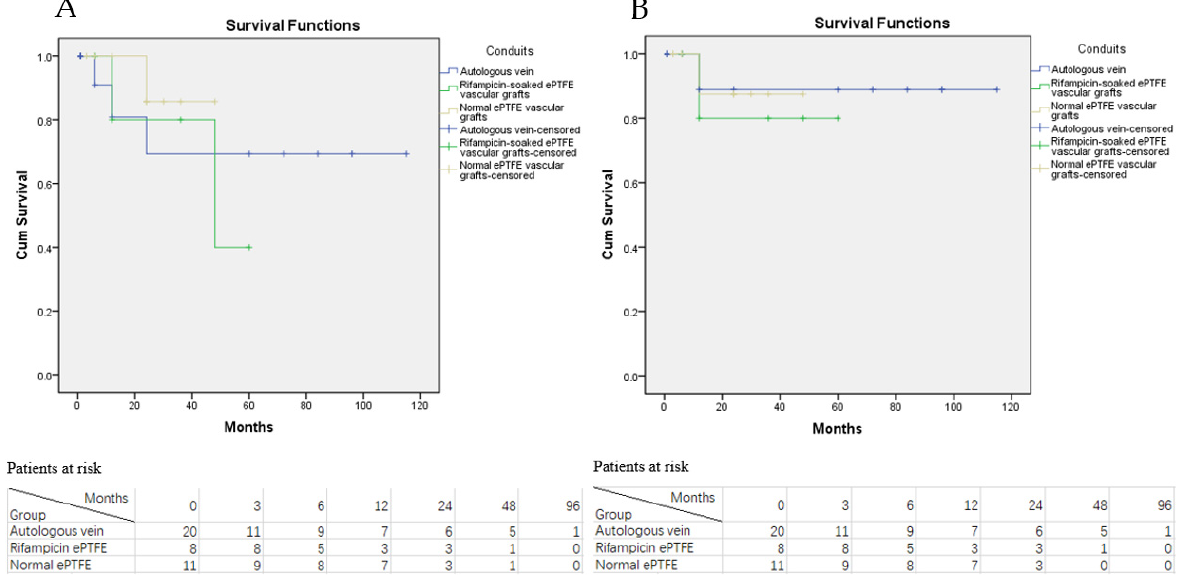
Figure 6. Kaplan-Meier survival curve of graft patency grouped by different bypass graft conduits. ( A ) KM curve of primary graft patency of different bypass graft conduits with the numbers of patients at risk; ( B ) KM curve of secondary graft patency of different bypass graft conduits with the numbers of patients at risk.